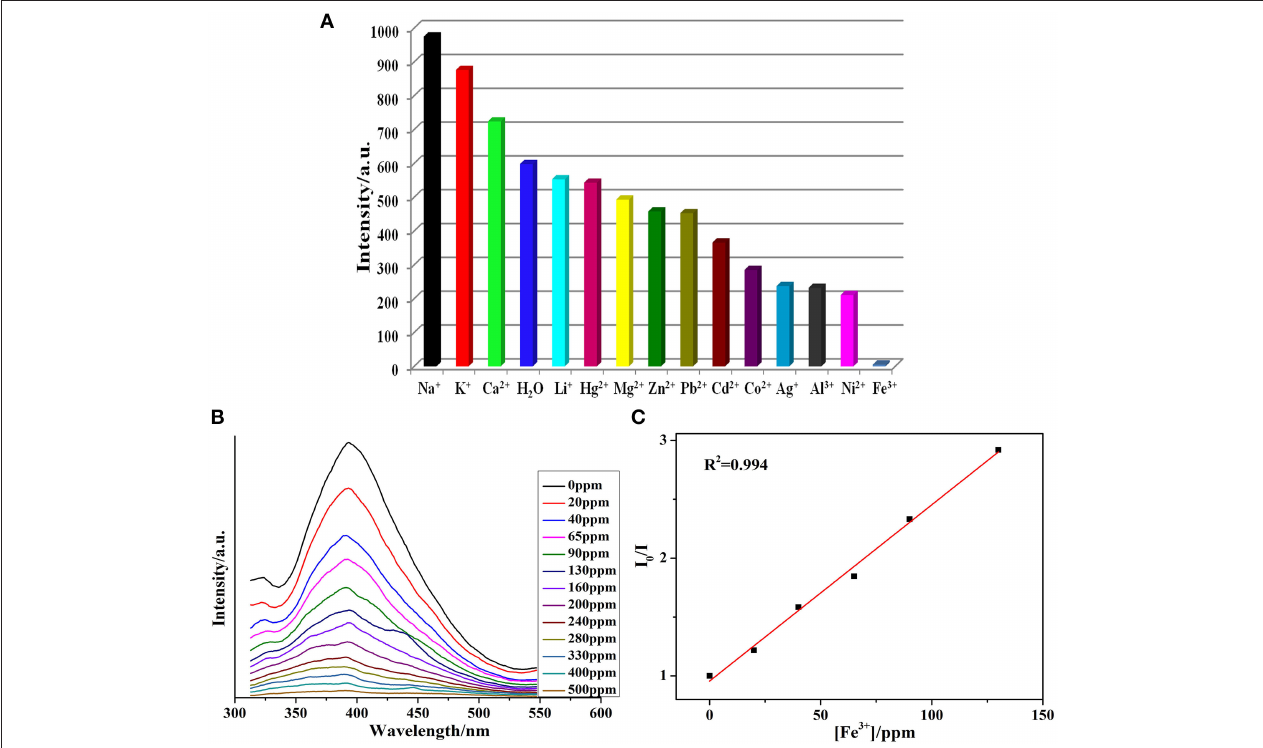
FIGURE 3 | (A) Photoluminescence intensity of 1 when it was dispersed in different metal ions solutions in H 2 O ( λ ex = 320nm); (B) Quenching in photoluminescence intensity after adding 1mM Fe 3 + solution; (C) SV plot after adding different Fe 3 + concentrations.